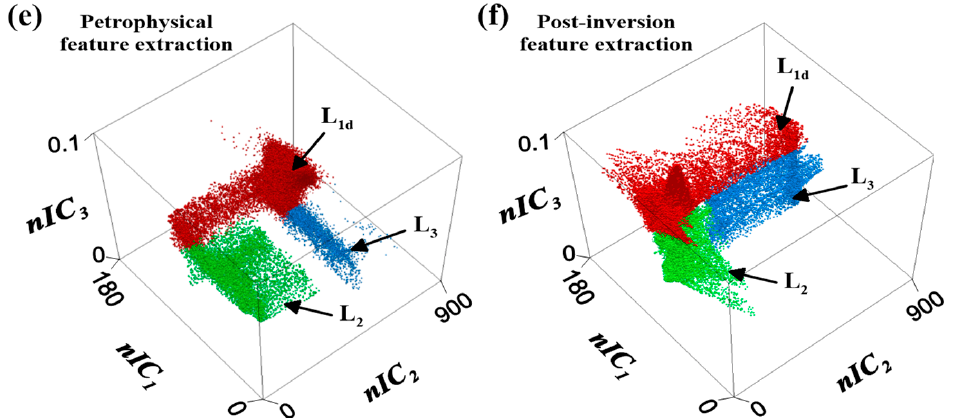
Figure 11. The 3D cross plots of pre-inversion and post-inversion physical properties compared to the extracted independent components: ( a ) pre-inversion physical properties of background geological features; ( b ) pre-inversion physical properties of alteration events overlapped on the background geology (transparent); ( c ) post-inversion physical properties of background geological features; ( d ) post-inversion physical properties of alteration events overlapped on the background geology (transparent); ( e ) independent components of pre-inversion petrophysical feature extraction; ( f ) independent components of post-inversion feature extraction.